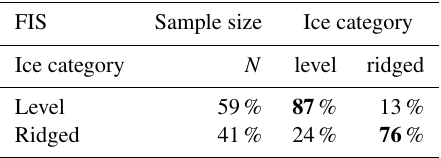
Table 2. Confusion matrix for the level ice vs. ridged ice (cate- gories DIR 2 to 4) in the RF classification for the whole test period. The largest estimated DIR category for each reference category is marked in